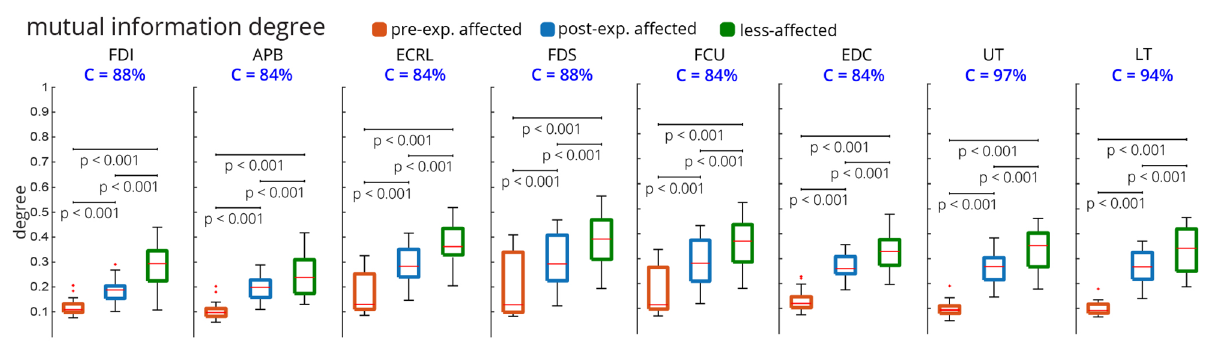
Figure 5. The median InfoMuNet (i.e., the connectivity network of median mutual information between muscle pairs) across all trials of all subjects is shown in two different formats. ( a ) The mutual information heatmaps across all subjects show that the pairwise mutual information increases across all nodes (muscles) from the pre-exposure affected to post-exposure affected and less-affected limbs. ( b ) The mutual information networks also show an increase in both pairwise mutual information (the edges’ line widths) and the muscles’ degrees (the nodes’ radii). MI = Mutual Information.